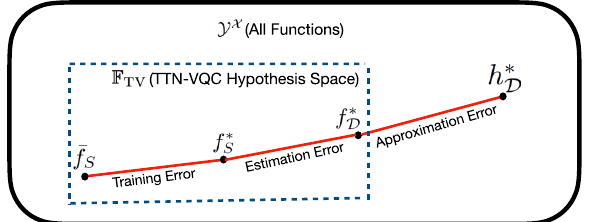
Fig. 1 An illustration of error decomposition technique. h (cid:2) is a D smooth target function in a family of all functions Y X over a data distribution D ; F TV denotes the family of TTN-VQC operators as represents the optimal hypothesis shown in the dashed square; f (cid:2) D from the space of TTN-VQC operators over the distribution D ; f (cid:2) S denotes the best empirical hypothesis over the set of training samples S ; f S is the returned hypothesis based on the training dataset S .